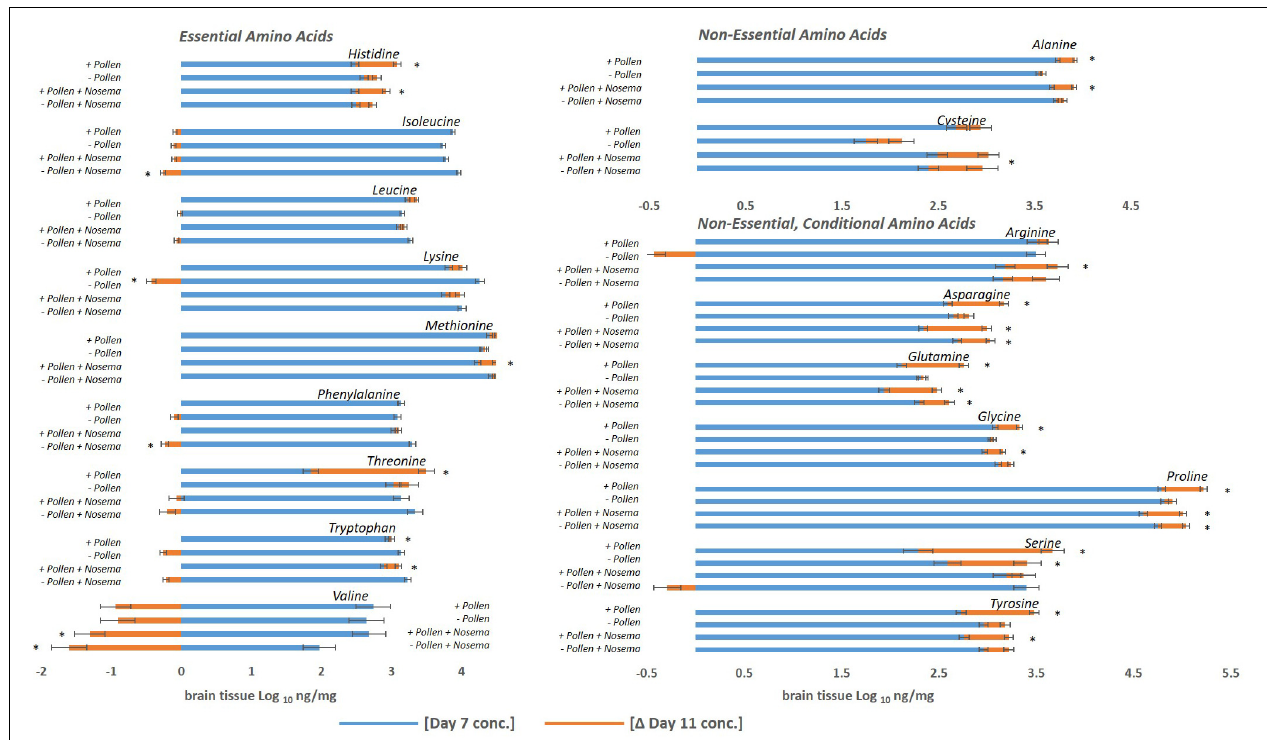
FIGURE 2 | Amino acid levels in the honey bee brain with age: ± pollen, ± Nosema ceranae . The blue bars represent the mean concentration of amino acids present in bees at Day 7. The orange bars represent the mean difference in concentration in bees at Day 11 ( (cid:49) Day 11). In other words, blue bars represent the mean concentration at Day 7, and the orange bars denote the change with age by Day 11. Negative changes with age (Ex. Valine) are represented by orange bars to the left. They can be interpreted as the mean concentration difference from Day 7. For example, valine levels in pollen-fed bees was approximately 2.7 ng/mg and Day 11 was approximately 1.8 ng/mg. ∗ Asterisks denote significant changes from Day 7 to Day 11 ( p ≤ 0.05, three- way ANOVA, Tukey-HSD). Each group represents the average of 15 bees analyzed individually for 18 amino acids, N = 120.